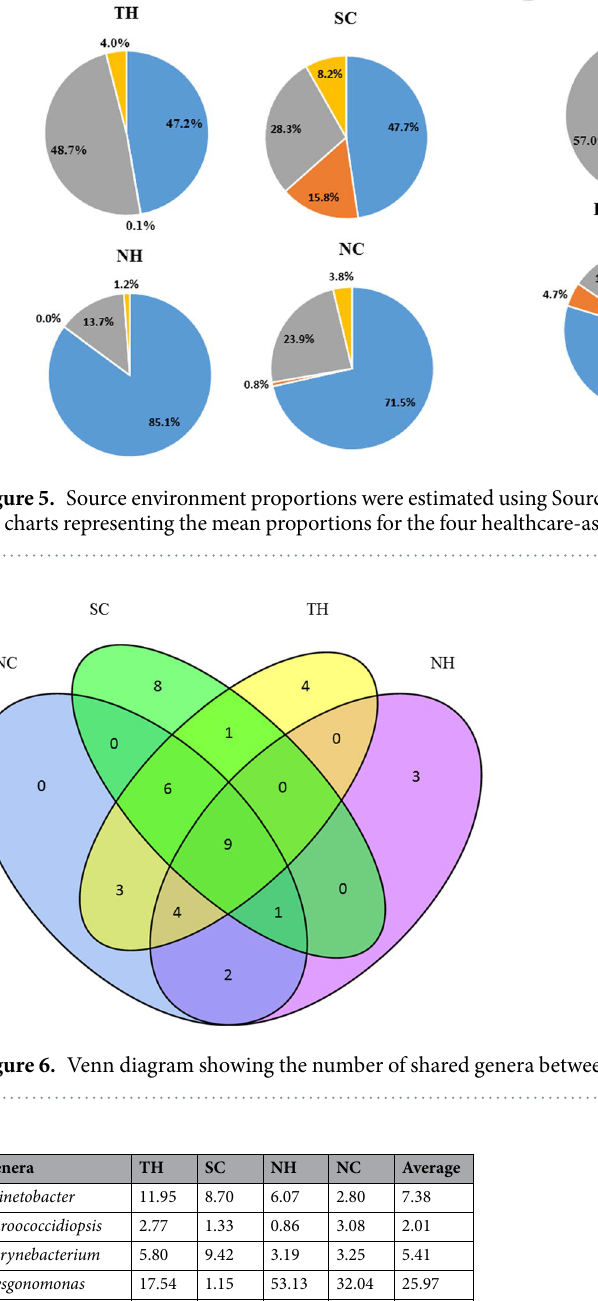
Table 3. Mean relative abundances of the core genera that were shared by all the areas a . a The microbial species in this table are those identified as members of the core microbiota as reported in Figure